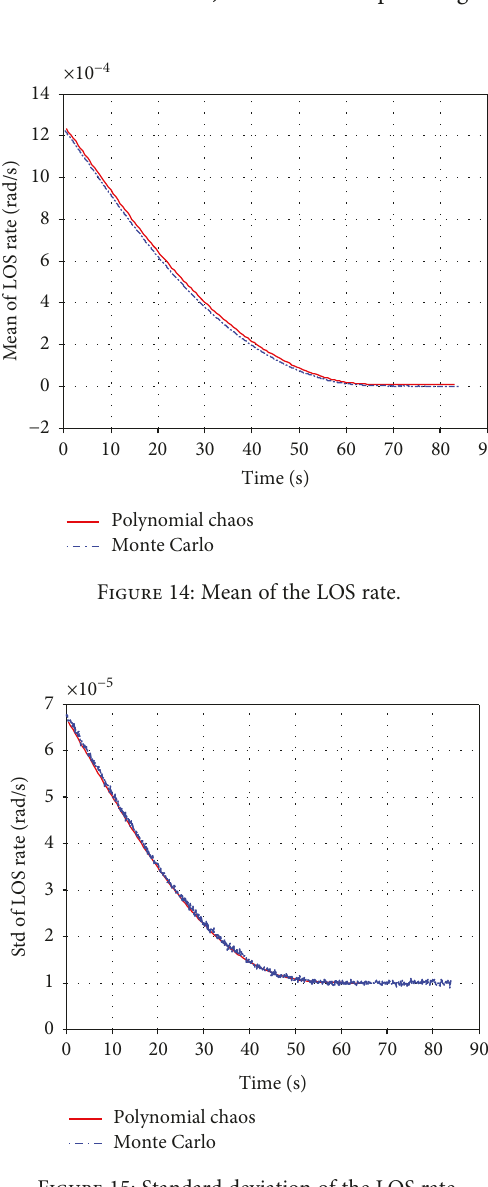
Figure 15: Standard deviation of the LOS rate.